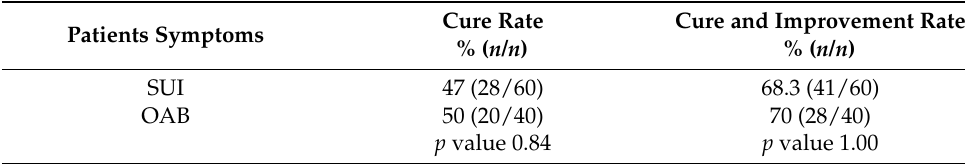
Table 3. Cure and Improvement rate at 2 months follow-up.